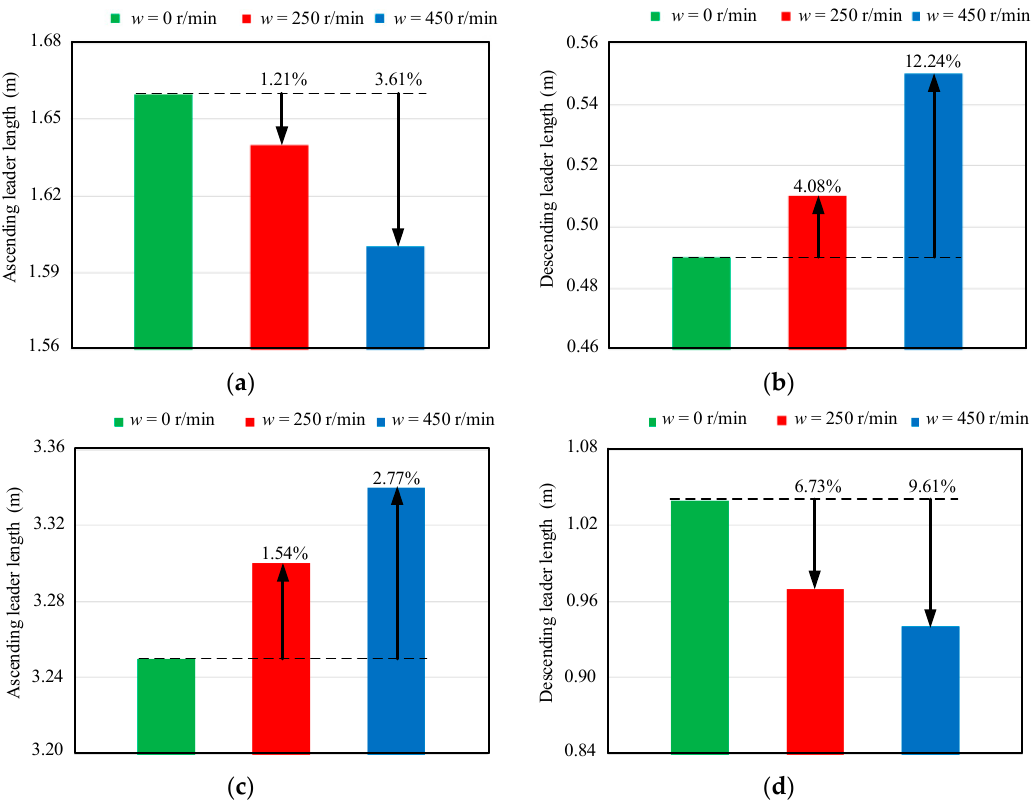
Figure 8. Relationship between the leader length and rotation speed in different air gap. ( a ) ascending leader length in 2 m air gap; ( b ) descending leader length in 2 m air gap; ( c ) ascending leader length in 4 m air gap; ( d ) descending leader length in 4 m air gap.